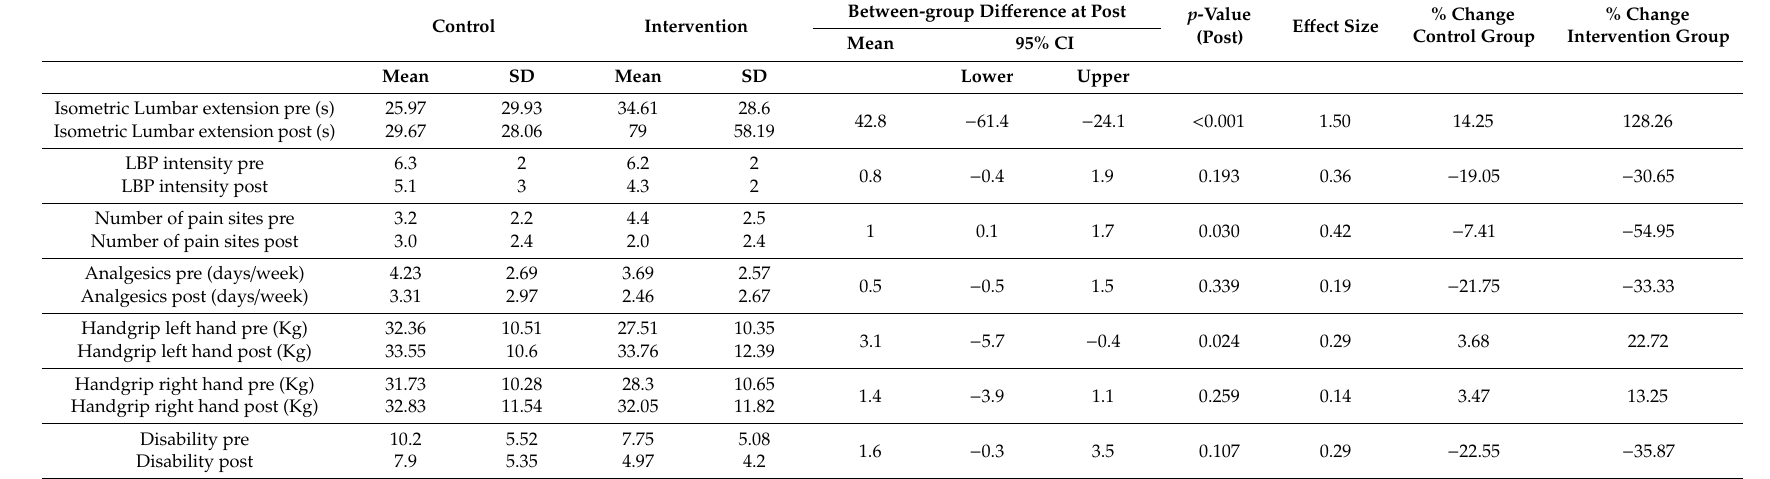
Table 3. Results from the other primary and secondary outcomes ( n = 85). SD = Standard Deviation; CI = Confidence Interval. Control